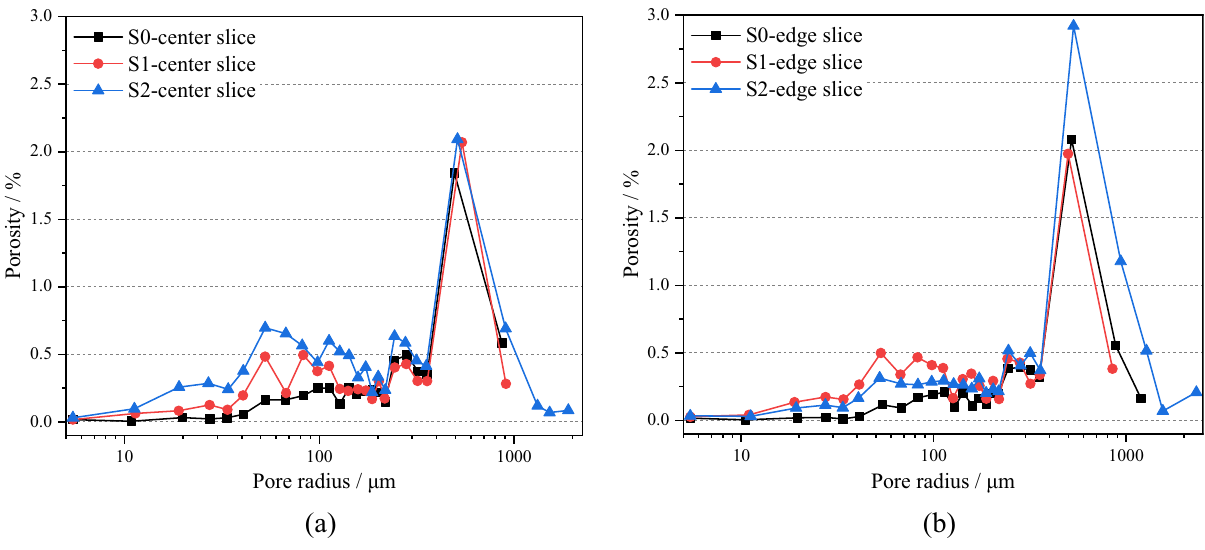
Figure 11: Pore size distributions: ( a ) center slice and ( b ) edge